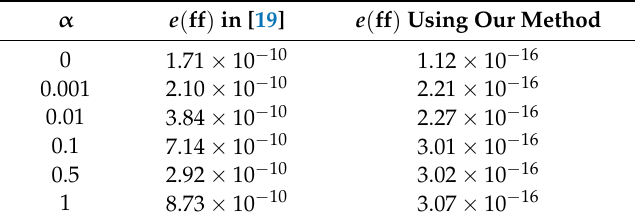
Table 1. Comparison between our results and the results in Reference [20] for Example 1.